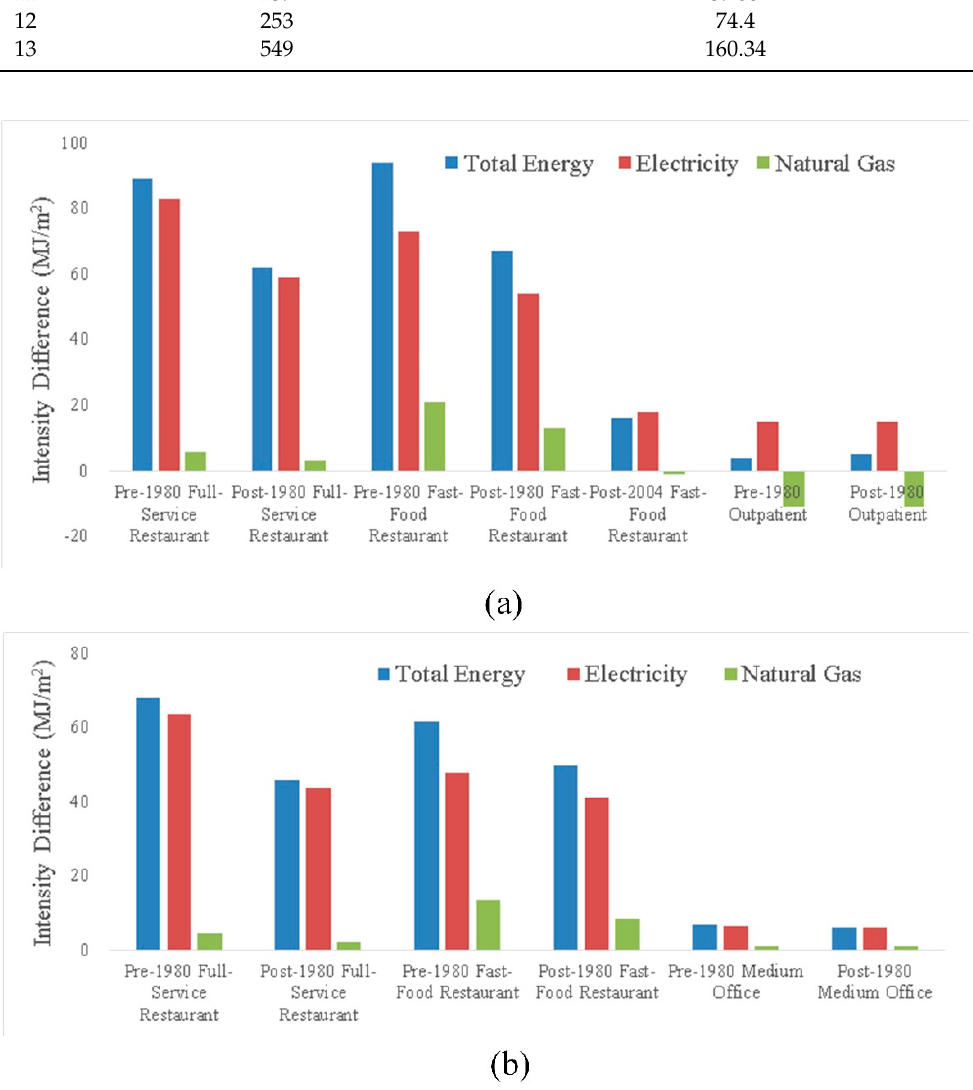
Figure 4. Annual energy savings (MJ / m 2 ) for green roofs on the tested buildings compared to traditional roofs under the A1F1 emission scenario in 2050: ( a ) Glendale; ( b ) Koreatown.